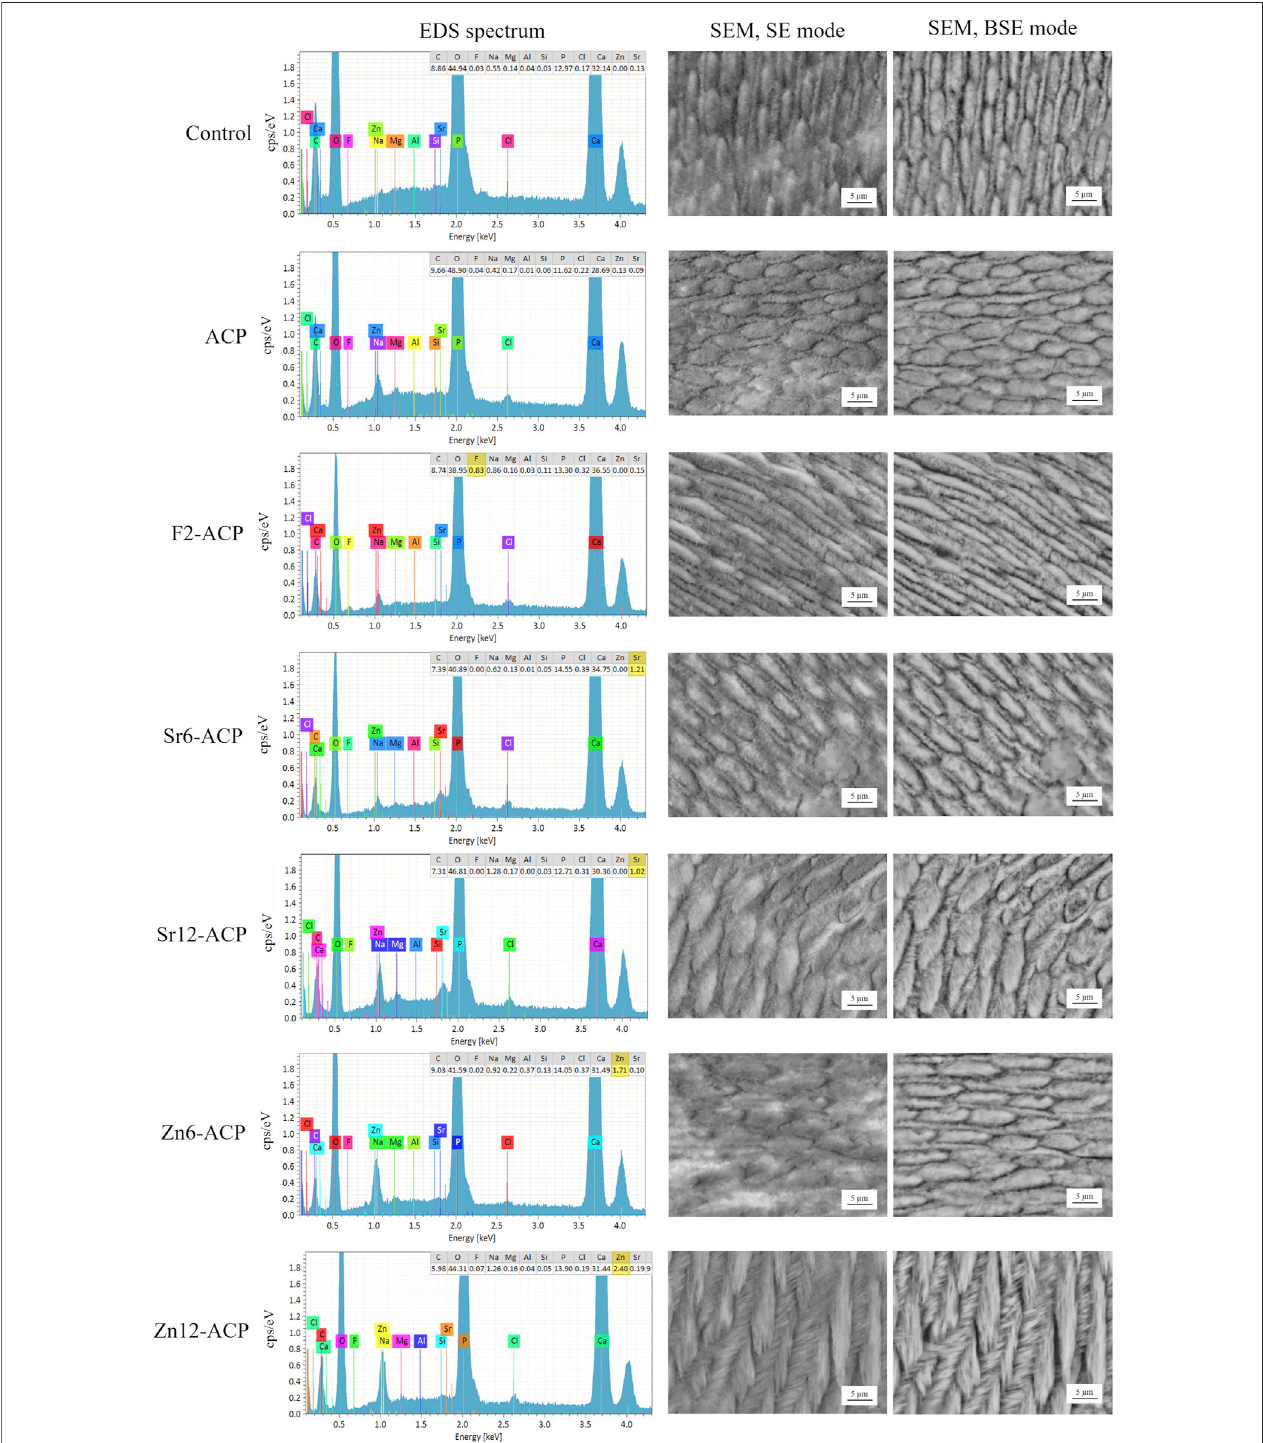
FIGURE 3 | EDSspectraandSEMmicrographsofdemineralizedhumanenamel(control)andenamelsurfacestreatedwithACPmaterialsfor24 h.Thecompositionofpristine enamelsurfacesindicatesthepresenceofmagnesium-andcarbonate-dopedHAtogetherwithsodiumchloride.Shallowtracesofaluminumandsiliconweresometimesdetectedasa consequenceofpolishingprocedures.ACP-treatedsurfacesshowedaverysimilarspectrumtothatofpristineenamel.Enamelsurfacestreatedwiththeion-dopedACPcompounds clearlyshowedthepeakscorrespondingtothedopingelement,yetthenormalizedwt.%ofthedopingelementwasmuchloweranddidnotincreasewhenitspresencewastwice asmuchintheACPcompound.NexttoeachEDSspectrumisacorrespondingSEMmicrographat×5,000magni fi cationacquiredinsecondaryelectronsmodeandinbackscattered electronsmode.BothZn12-ACPandSr12-ACPshowedthepresenceofacompactlayerofcrystalliteswithepitaxialgrowthremineralizingenamelstructures.F2-ACPandnon-doped ACP showed a layer made by smaller cristallites without a de fi ned orientation.